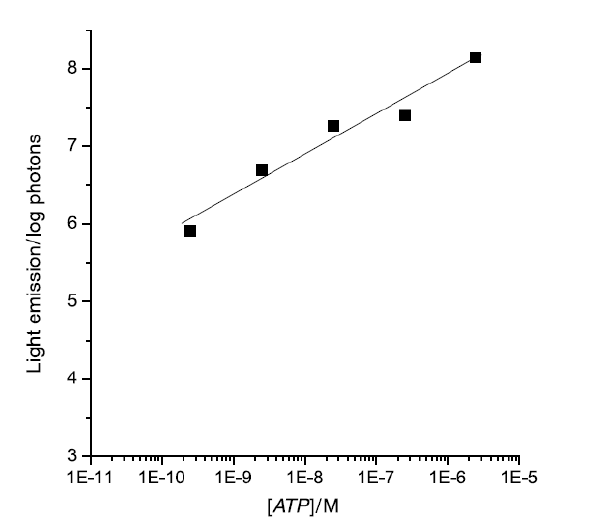
Figure 11. Representative ATP standard curve for light emission as function of ATP concentration in the range of 1x10 -10 to 1x10 -5 M. Reproduced from